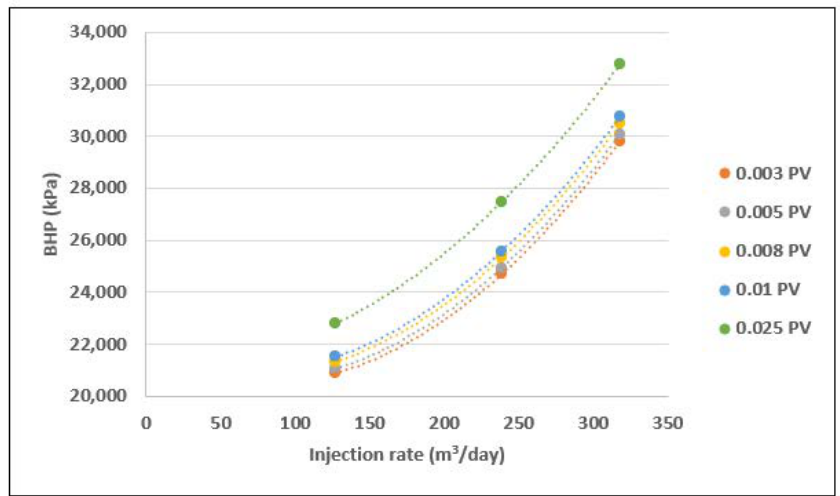
Figure 17. Plot of BHP versus injection rate for part of water injection baseline. Oppositely, the analysis of BHP response during polymer injection shown a signal of active apparent shear-thickening behavior. This is demonstrated through plots of BHP vs. injection rate at several injected pore-volumes (PV’s) (Figure 18). The increasing slope is a predicted signature of shear thickening as viscosity increases with Darcy velocity.